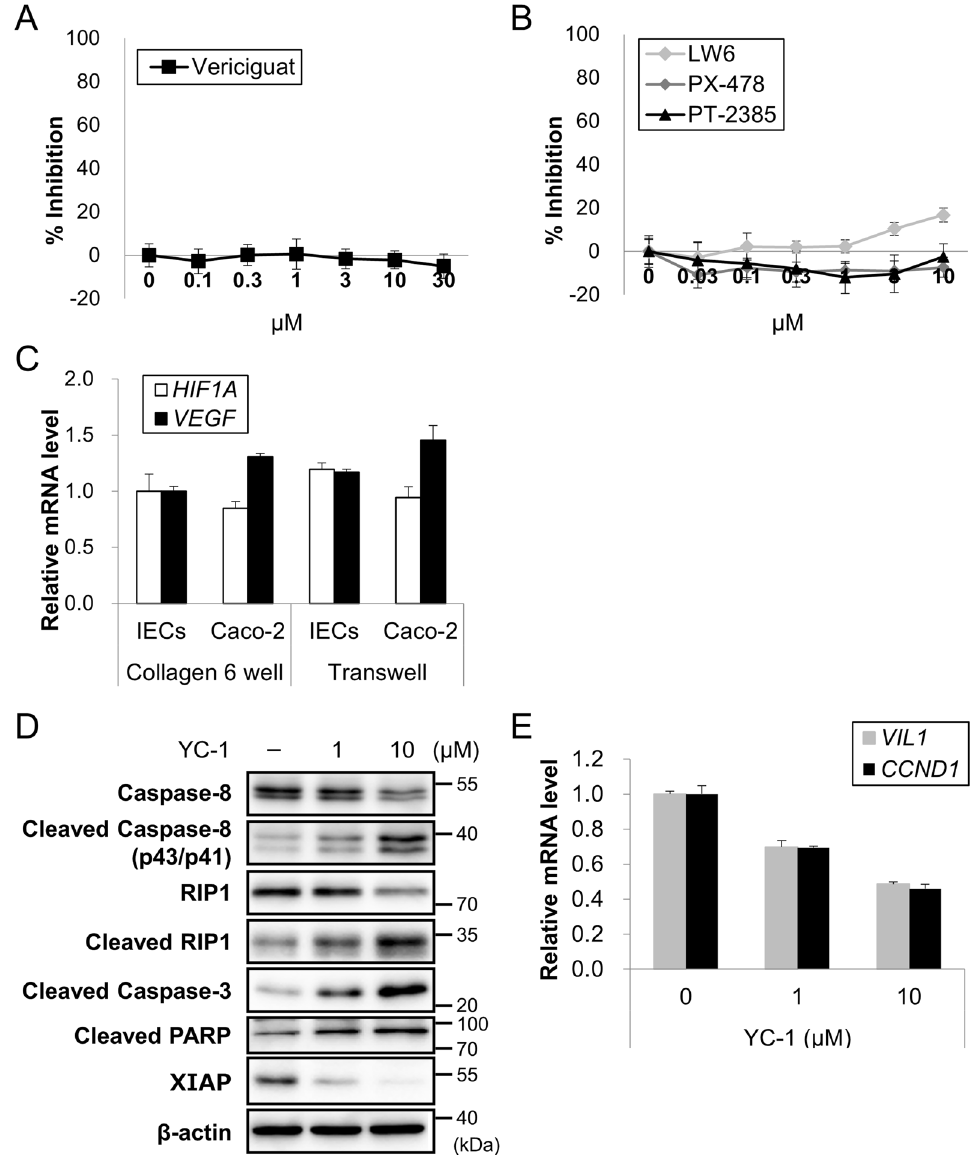
Figure 5. Mechanism of action of YC-1-induced cell death in organoid-derived IECs. ( A, B ) Dispersed hiPSO-derived IECs were treated with vericiguat ( A ) or LW6, PX-478, or PT-2385 ( B ) at the indicated doses for 48 h. Cell viability was determined by CellTiter-Glo 3D reagents. Assays were performed in n = 6 biologically independent replicates (mean ± S.D.). ( C ) Dispersed hiPSO-derived IECs or Caco-2 cells were seeded in collagen I-coated six-well plates or Transwells and cultured as monolayers according to the procedure described in the Methods. After cell harvesting, the HIF1A and VEGFA mRNA levels were determined by qRT-PCR and normalized to the levels of 18S rRNA. Assays were performed in n = 3 biologically independent replicates (mean ± S.D.). ( D ) Dispersed hiPSO-derived IECs were treated with 0, 1, and 10 µM YC-1 for 14 h. Cells were harvested and western blot analysis was performed using anti-caspase-8, anti-RIP1, anti-cleaved caspase-3, anti- PARP, anti-XIAP, and anti-β-actin antibodies. Full-length blots/gels are presented in Figure S4. ( E ) Dispersed hiPSO-derived IECs were treated with 0, 1, and 10 µM YC-1 for 48 h. The cells were harvested, and the mRNA levels of each gene were determined by qRT-PCR and normalized to 18S rRNA levels. Assays were performed in n = 3 biologically independent replicates (mean ±